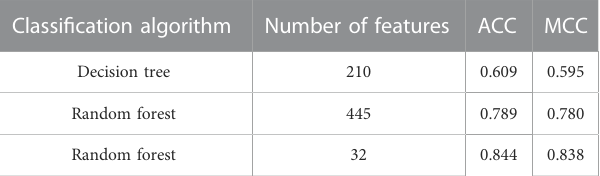
TABLE 1 Performance of the key classi fi ers.